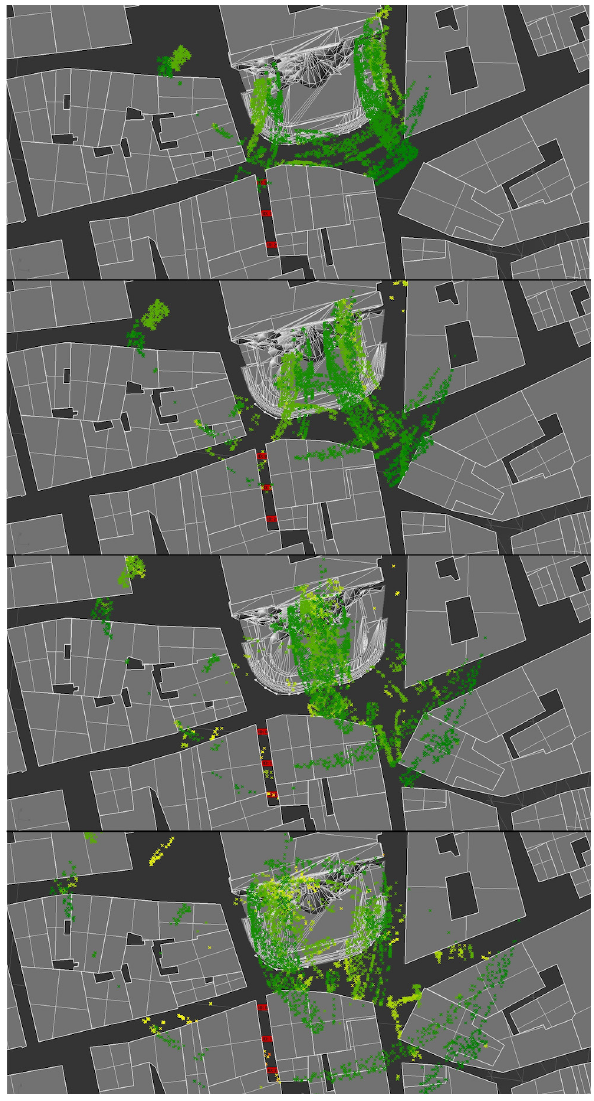
Figure 13: Ray-tracer simulation, showing Vicolo del Forno, where the red particles are visible. Frames correspond to 29-35-42-50 milliseconds after the source started